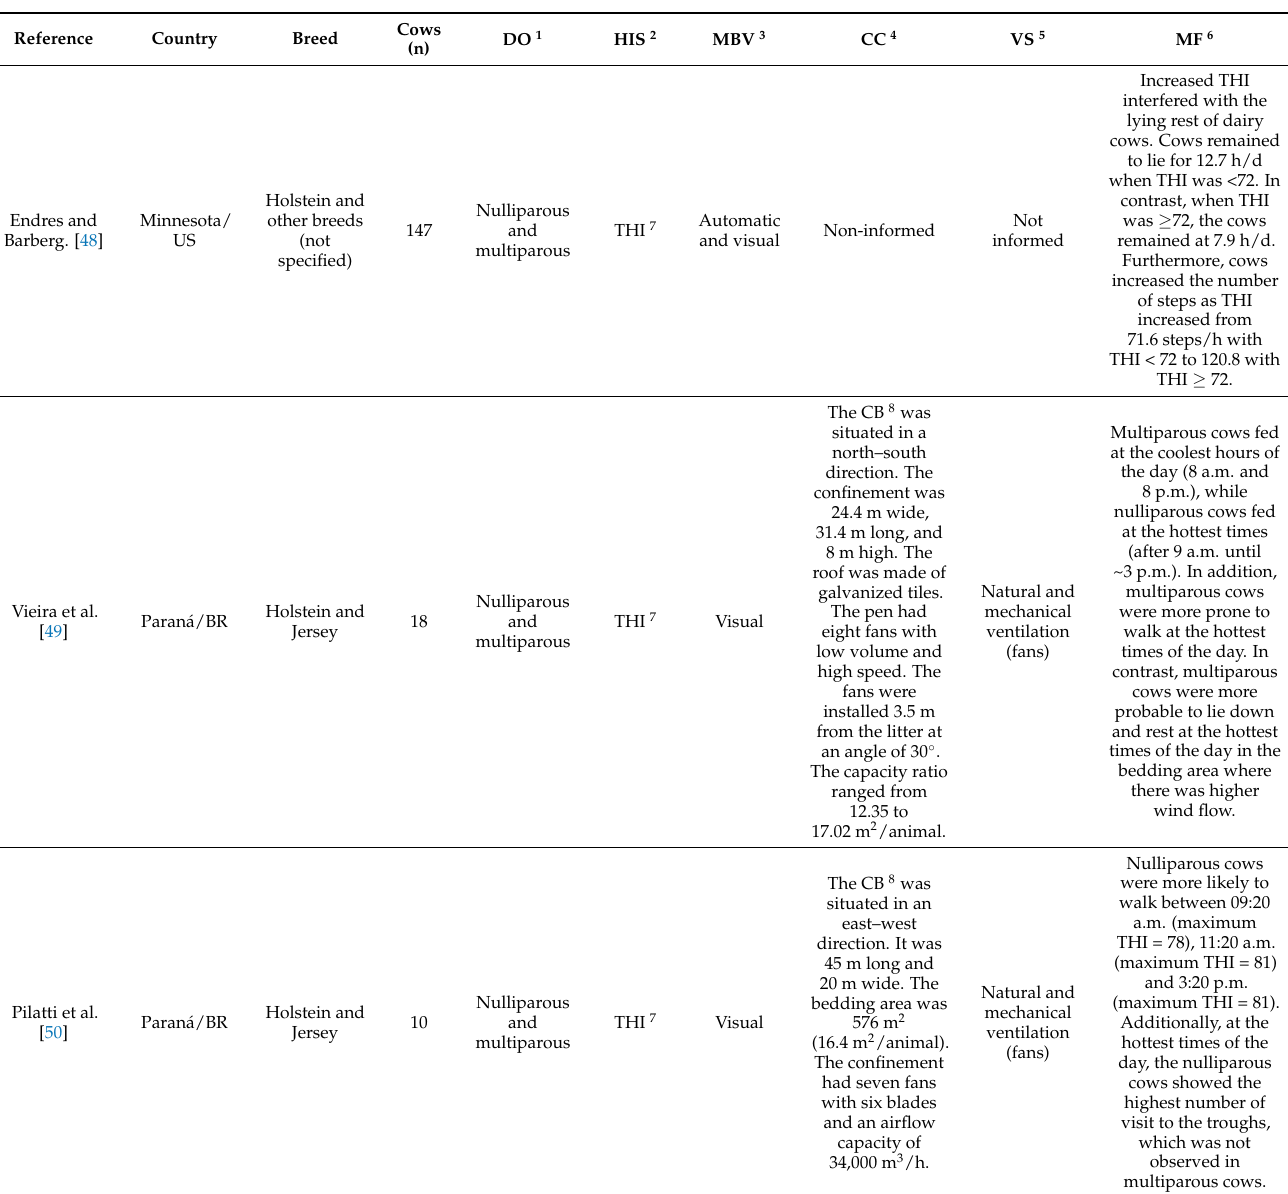
Table 2. Characterization of the studies included in the systematic